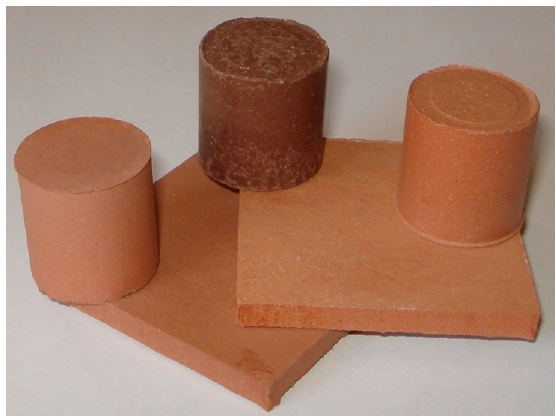
Figure 6. Ceramic samples obtained from modified saponite product.